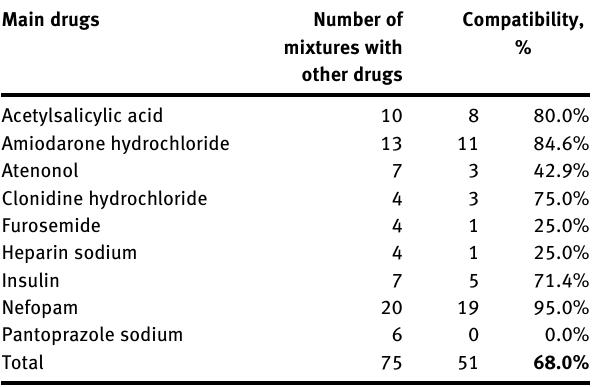
Table  : Summary of the overall compatibility for each main drug. Main